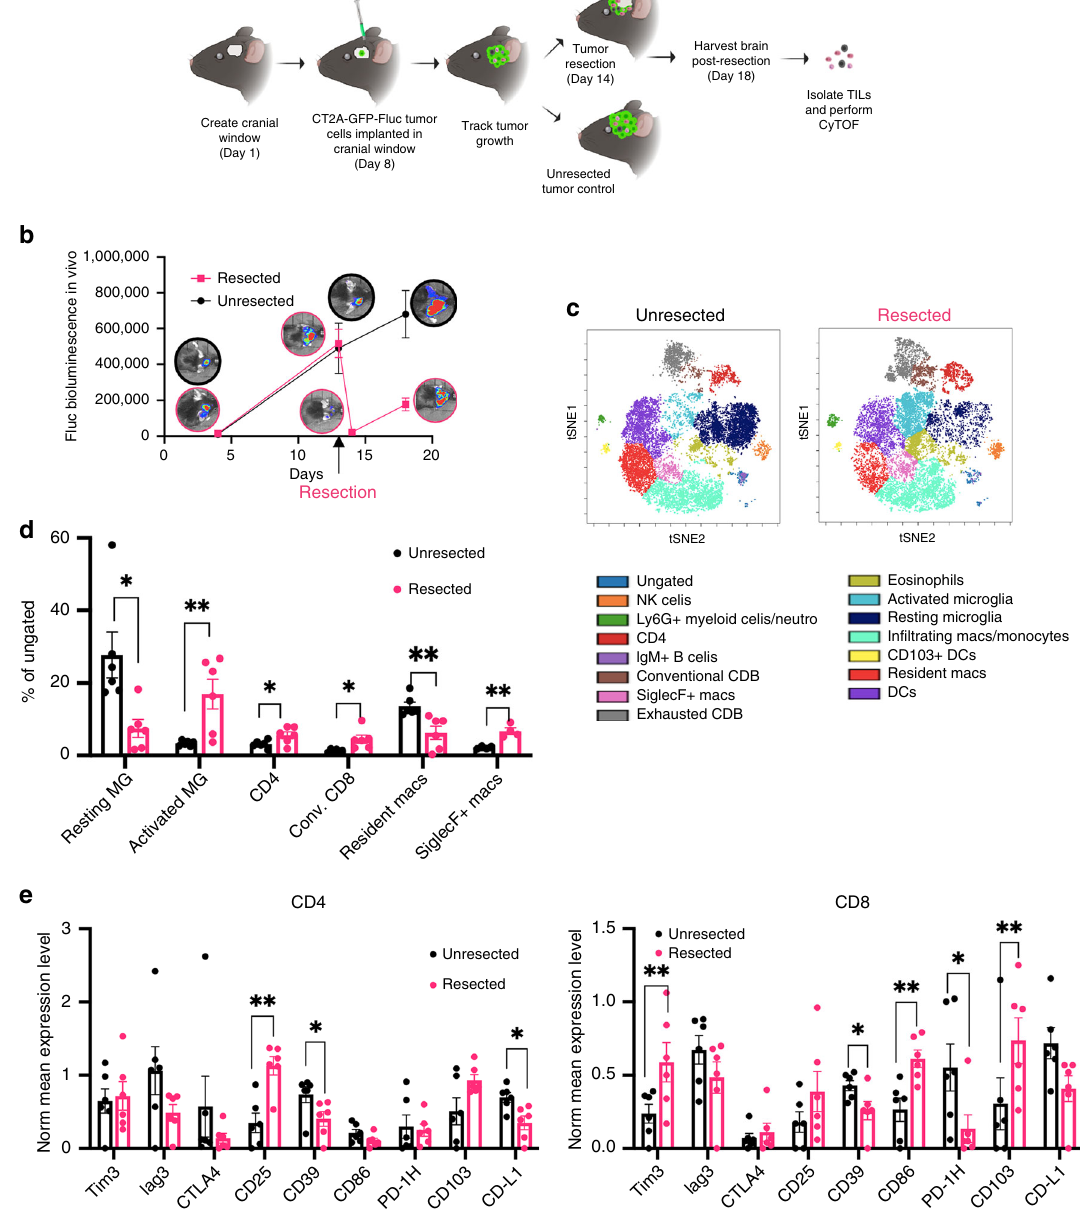
Fig. 4 Tumor resection invigorates an anti-tumor immune response. a Schematic of the experimental plan. b C57Bl/6 mice were implanted with 2 × 10 5 CT2A tumor cells in the cranial window. On day 14, tumors were resected using fl uorescent guided microscopy. Tumor volume was monitored using bioluminescent imaging and plotted against time. Data represents average ± SE. n = 6 mice/group for two independent experiments. c FlowSOM analysis of tumor tissue collected 4 days post tumor-resection or unresected CT2A showing various populations de fi ned based on expression analysis on various clusters. Populations were de fi ned as following: NK cells (NK1.1 + , CD49b + ), Ly6G + myeloid cells/neutrophils (Ly6C + /Ly6C + /CD11b + /CD45 + ), CD4 + (CD3 + /CD4 + /CD45 + ), IgM + B cells (B220 + IgM + ), Conventional CD8 + (CD3 + /CD8 + /CD45 + ), SiglecF + macs (SiglecF + CD45 + MHC-II + ) exhausted CD8 (CD39 + Tim3 + Lag3 + CD8 + ), eosinophils (SiglecF + CD45 + MHCII-ve), resting microglia (CD11b low/CD45 low/MHCII low), activated microglia (CD11b low/CD45 low/MHCII high), in fi ltrating macrophages/monocytes (CD11b + F4/80 + CD64 + Ly6C + ), CD103 + DCs (CD103 + CD11c + ), DCs (CD11c + MHCII + ). d % of cells for populations showing signi fi cant differences were plotted as average ± SE ( n = 6 mice/group, representative plot from two independent experiments). e Normalized mean expression values for various activation/inhibition markers in CD4 and CD8 T-cell populations in resected and unresected tumor samples were plotted as average ± SE ( n = 6 mice/group, representative plot from two independent experiments). Two- sided Student ’ s t test with Holm – Sidak corrections for multiple comparisons was applied. * p ≤ 0.05; ** p ≤ 0.005. a was created by authors using biorender tools